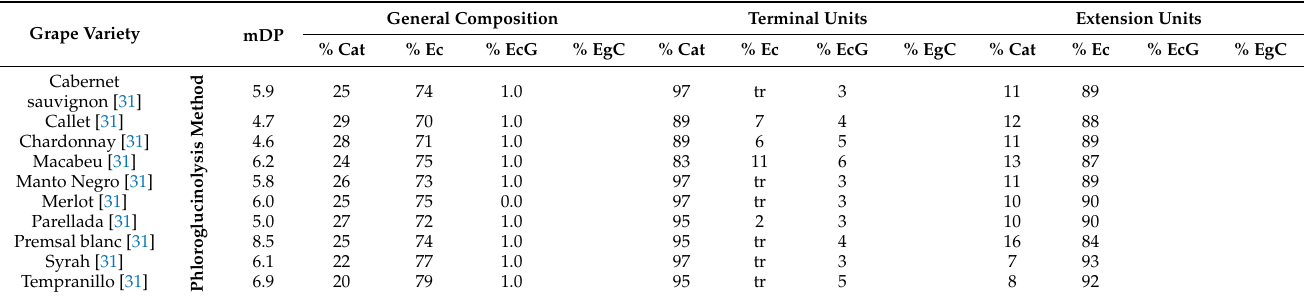
Table 9. Mean degree of polymerization (mDP) and structural composition of stem polymeric proanthocyanidins. Grape Variety